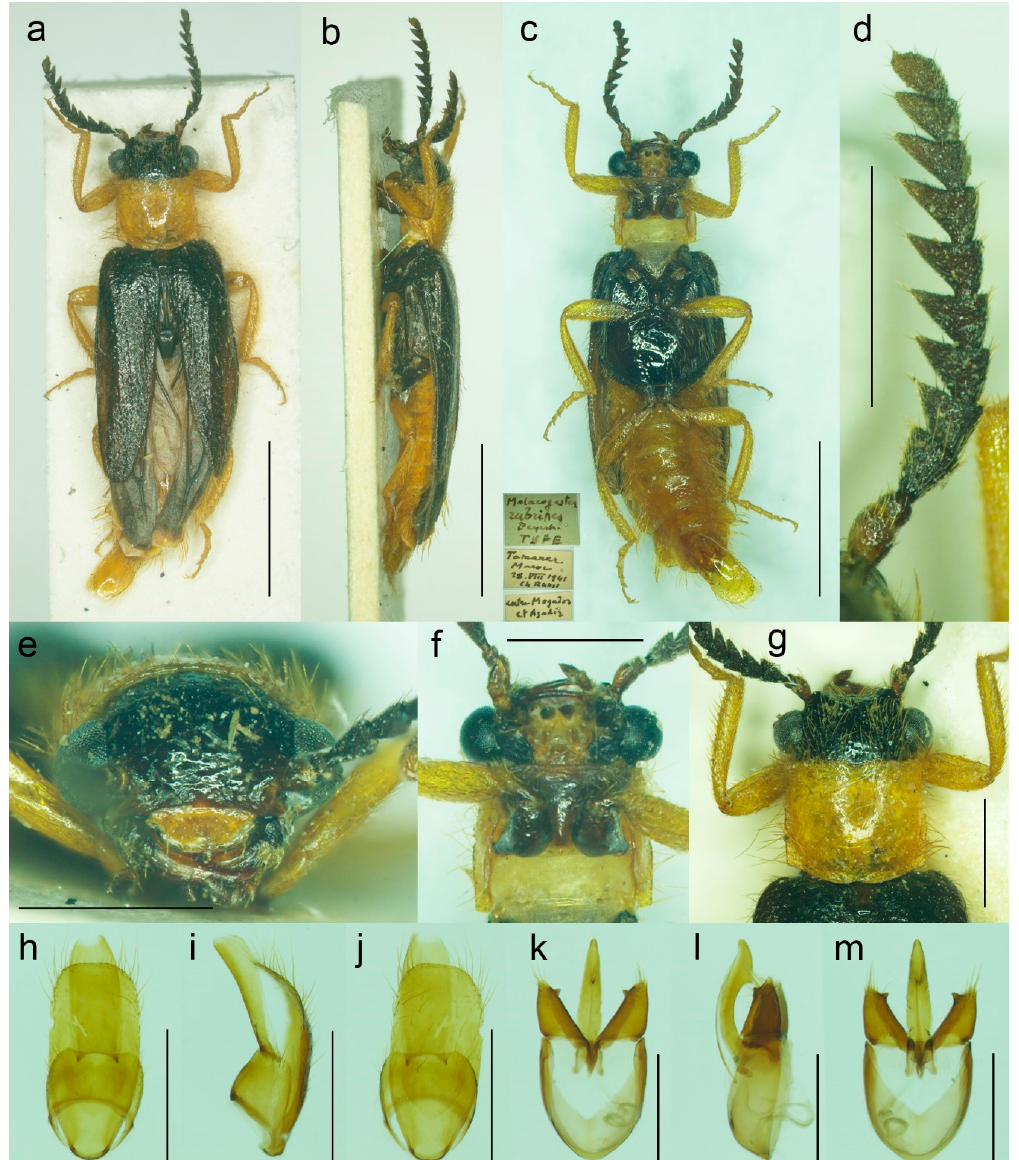
Figure 19. Malacogaster rubripes Peyerimhoff, 1949, male lectotype. ( a ) Habitus, dorsal view; ( b ) habitus, lateral view; ( c ) habitus, ventral view; ( d ) right antenna; ( e ) head, frontal view; ( f ) head and prothorax, ventral view; ( g ) pronotum, dorsal view; ( h ) genital capsule formed by tergites IX and X, and sternite IX, dorsal view; ( i ) genital capsule formed by tergites IX and X, and sternite IX, lateral view; ( j ) genital capsule formed by tergites IX and X, and sternite IX, ventral view; ( k ) aedeagus, dorsal view; ( l ) aedeagus, lateral view; ( m ) aedeagus, ventral view. Scale bars = ( a – c ) 2.5 mm; ( d – j ) 1.0 mm; ( k – m ) 0.5 mm.